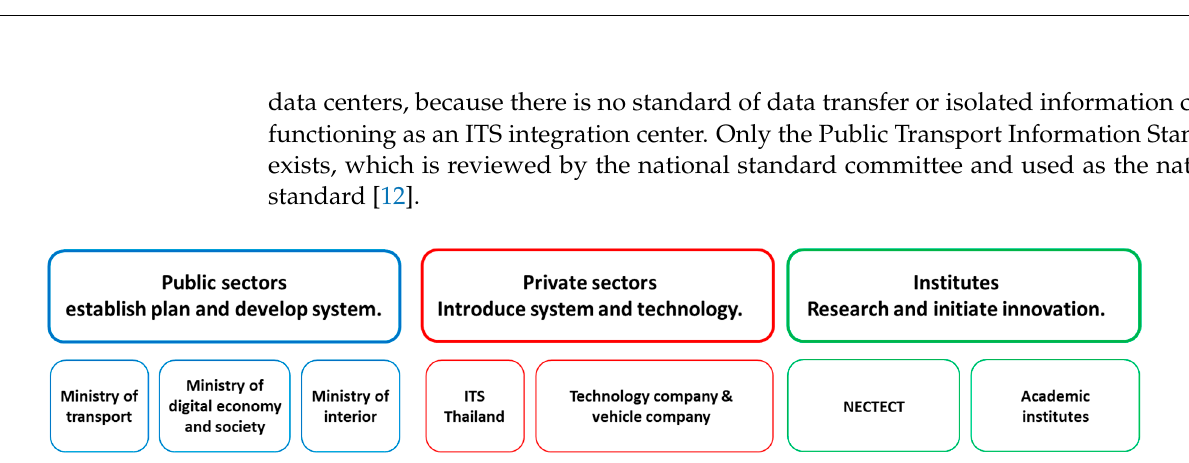
Figure 1. Organization on intelligent transport system (ITS) development in Thailand.